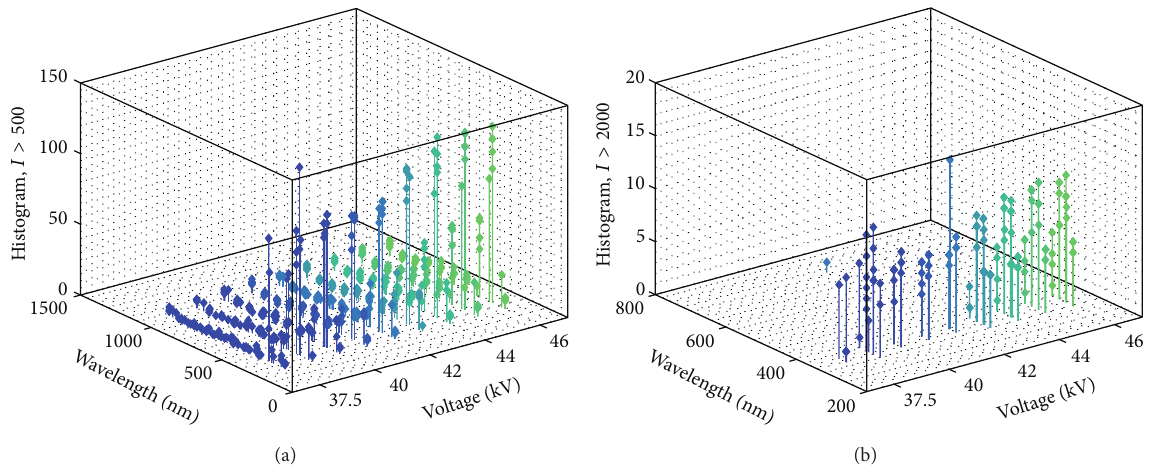
Figure 17: Summary of spectrum intensity histograms for different voltages: (a) 𝐼 > 500 and (b) 𝐼 > 2000 .